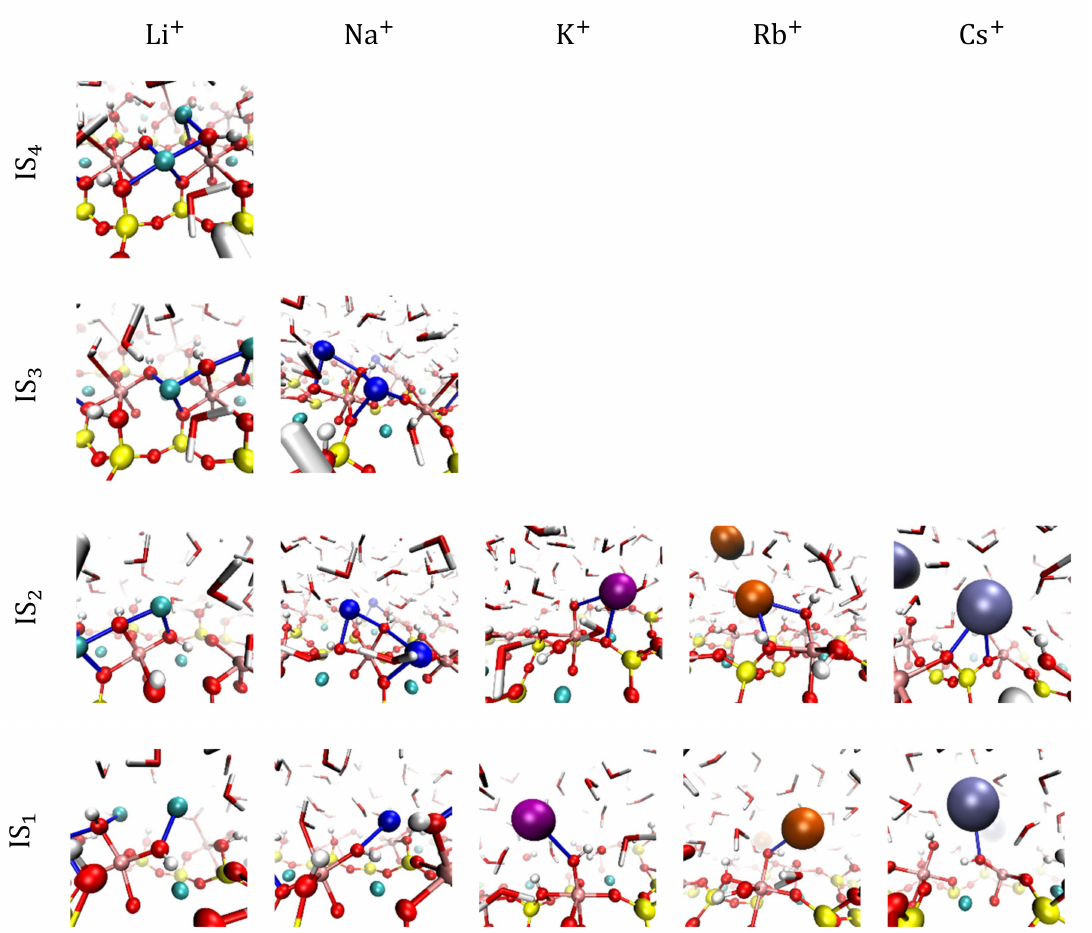
Figure 5. Alkali metal inner-sphere complexes with one, two, three, and four adsorption contacts with the negatively charged (110) spodumene surface. Surface charge density is − 0.125 C/m 2 . Li, Na, K, Rb and Cs atoms are represented by cyan, blue, magenta, orange and grey spheres, respectively. Contacts are highlighted in blue.